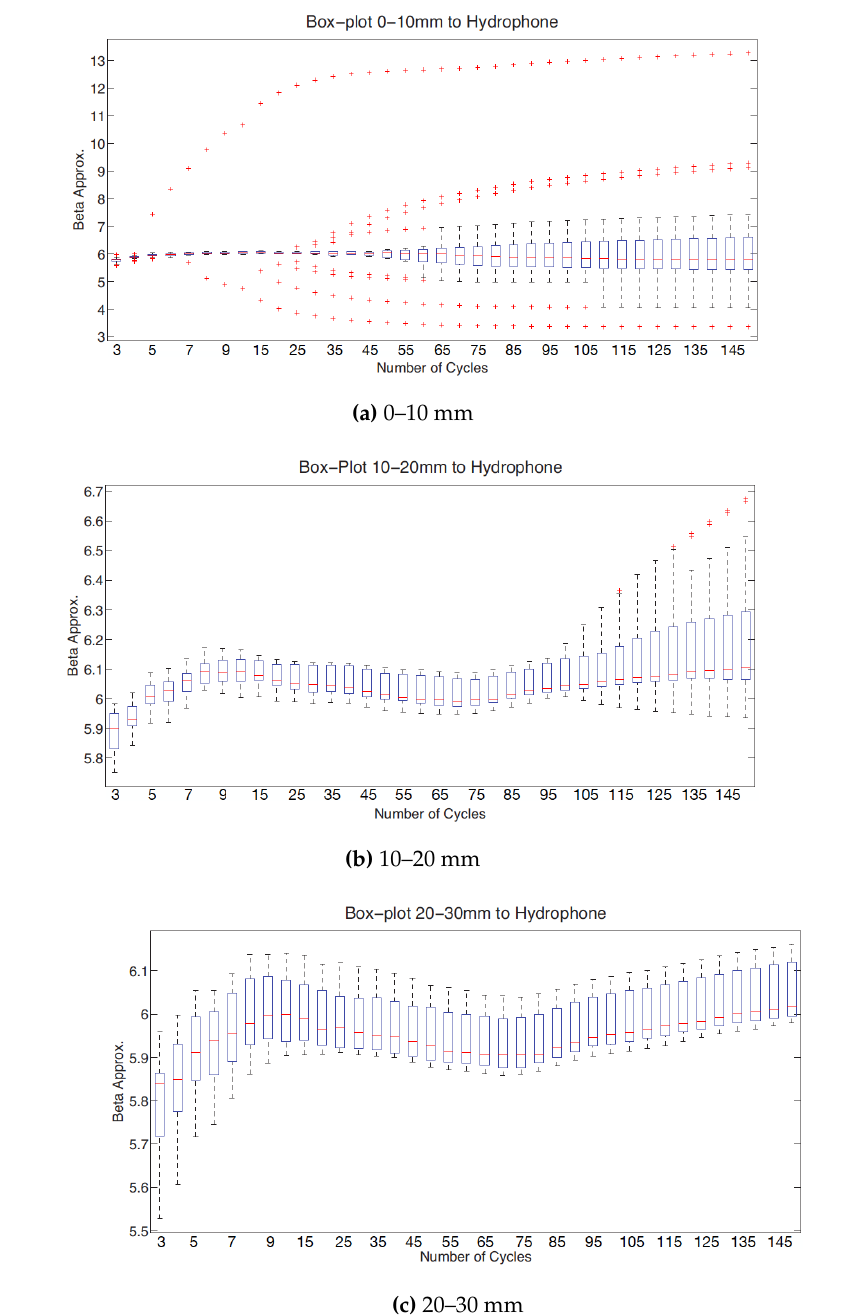
Figure 11. Box-plot beta versus cycles using a frequency of 5.9 MHz. Mean and standard deviation values are computed considering different distances specimen-hydrophone: in ( a ) distance 0–10 mm, in ( b ) distance 10–20 mm and in ( c ) distance 20–30